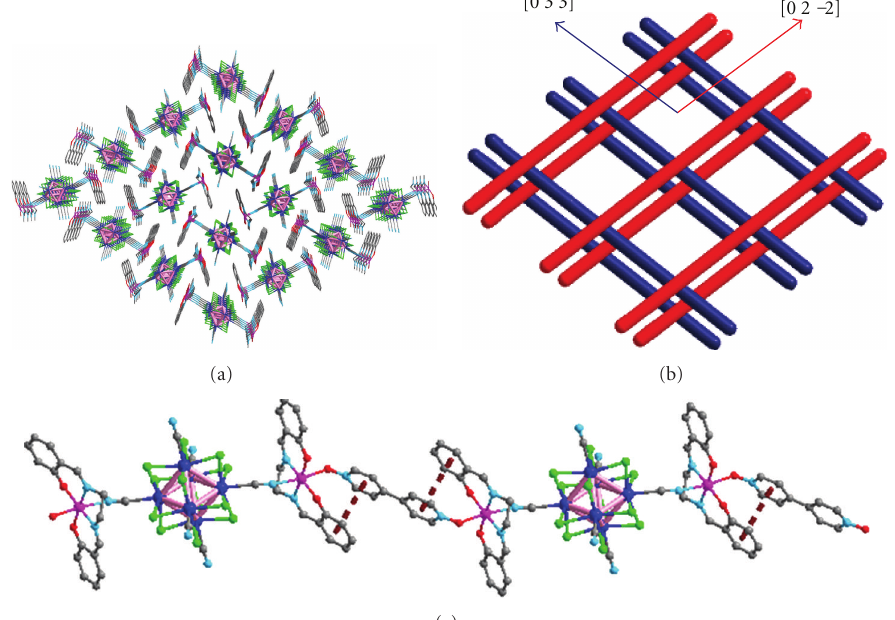
Figure 1: (a) A perspective view of the structure of 1 . Note that [Mn( Salen )(MeOH) 2 ] + cations are represented as space-filling mode and some cations are omitted to show the size and shape of the channel. (b) Schematic diagram showing the packing mode of the chains along [0 2 − 2] and [0 3 3] directions. (c) A projection of one anionic chain showing the linkages between the three components and π - π interaction between dpyo and the Salen ligand represented as dotted brown